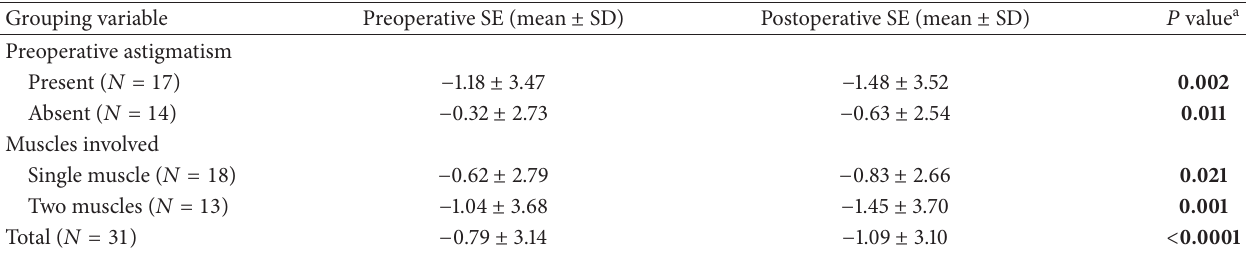
Table 2: Comparison of preoperative and postoperative refractive power in terms of spherical equivalent (SE).